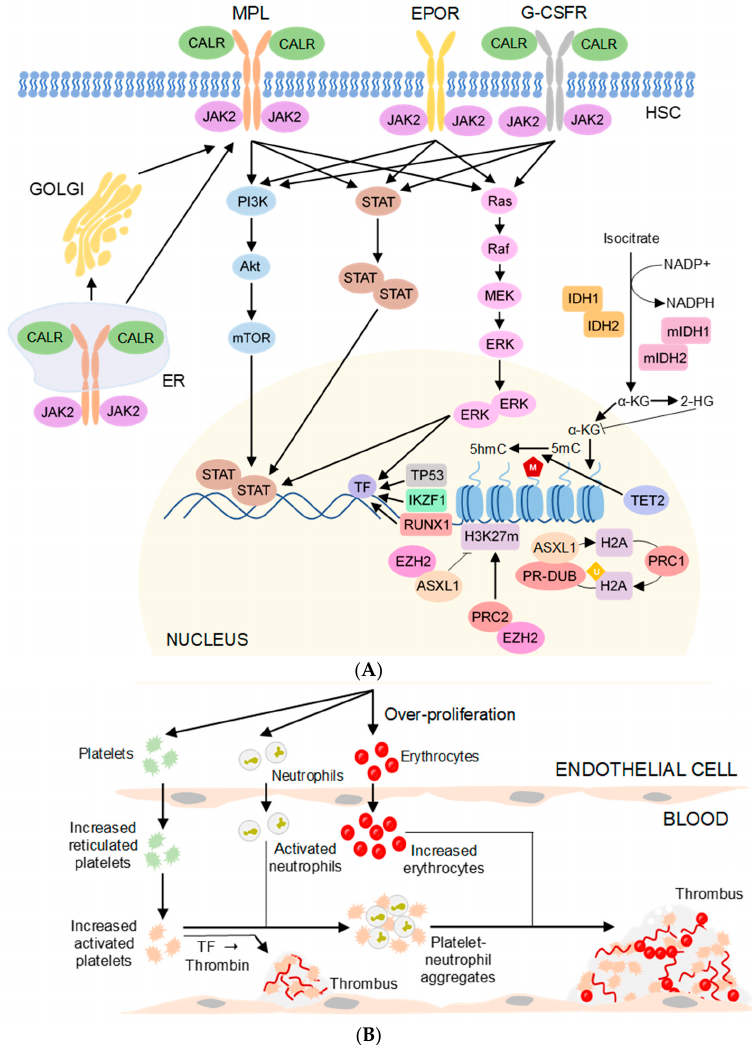
Figure 1. ( A ) Pathogenesis of thrombosis in MPN patients. Mutated JAK2, CALR, and MPL activate a JAK/STAT pathway, PI3K/Akt pathway, and MAPK/ERK pathway. Mutations in ASXL1 and TET2 cause epigenetic changes in DNA (ubiquitination, methylation and hydromethylation) and affect the differentiation of hematopoietic cells. All these lead to proliferation of blood cells at an abnormal rate. ( B ) The pathogenesis of thrombosis in MPN is complex and caused by multifacto- rial, other than the abnormal signalling transduction, platelet activation, endothelial cell dysfunc- tion, over-production of tissue factors, formation of platelet-neutrophil aggregates, and increased red blood cell mass may further contribute to the genesis of thrombi. Most of the gene polymor- phisms mentioned in this review take parts in initiating those abnormalities. Abbreviations: α -KG, α -ketoglutarate; 2-HG, 2-hydroxyglutarate; 5hmC,